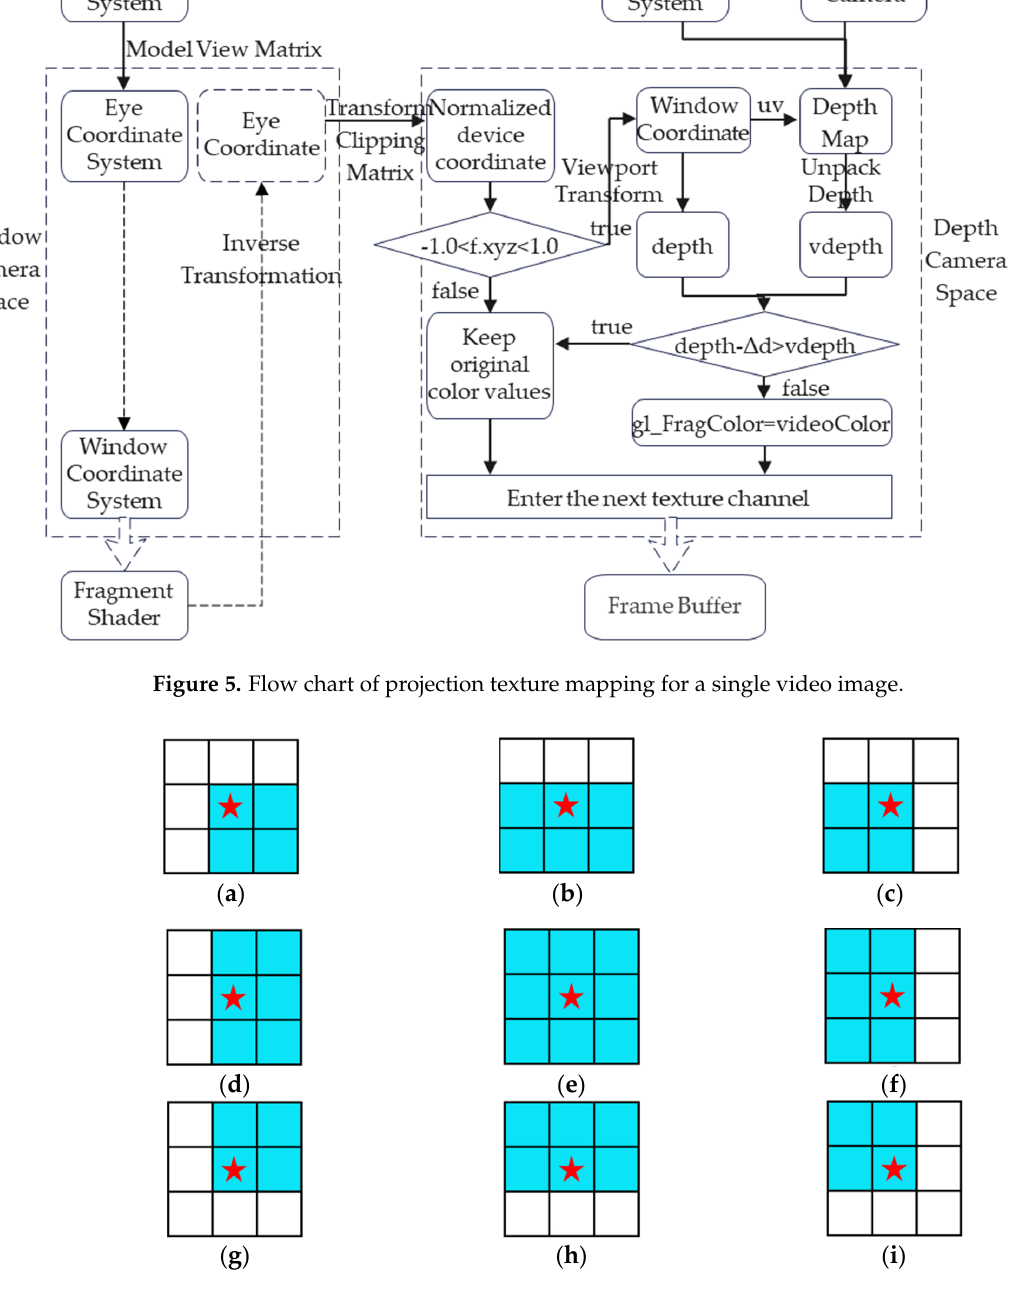
Figure 6. Position of fragment in video image. ( a – i ) show the nine position cases of slice elements in the video. Where the blue blocks indicate the slice elements located in the video image. The white blocks indicate slice elements that are outside the video image. The slice elements with red stars indicate the current slice element.